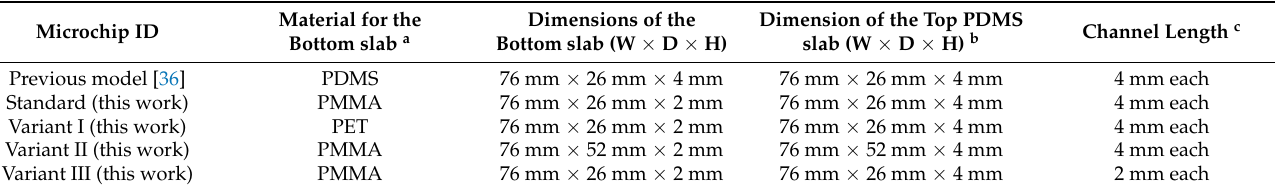
Table 1. Comparison of the structural architecture of the previous and current